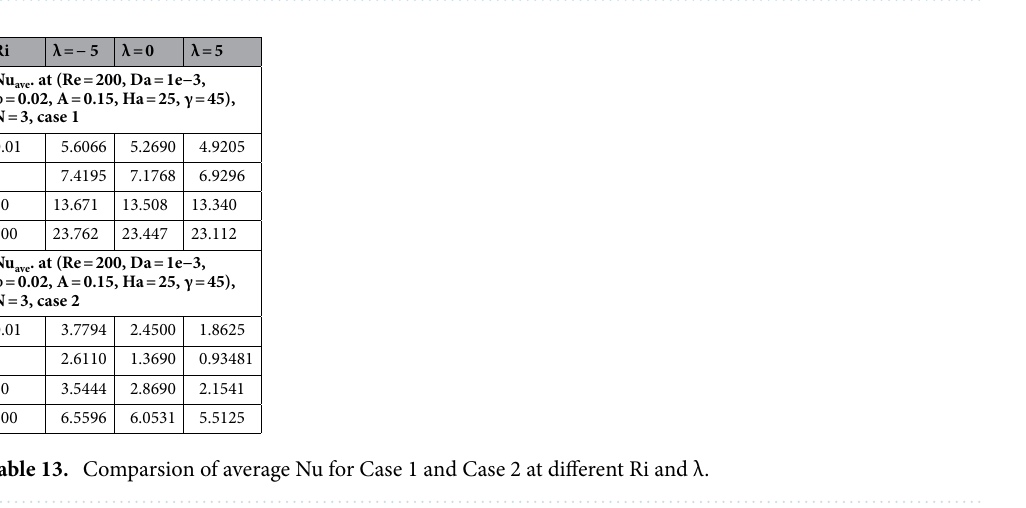
Figure 15. Local Nu numbers along sinusoidal wall at different Ri and Da numbers for Case 2.